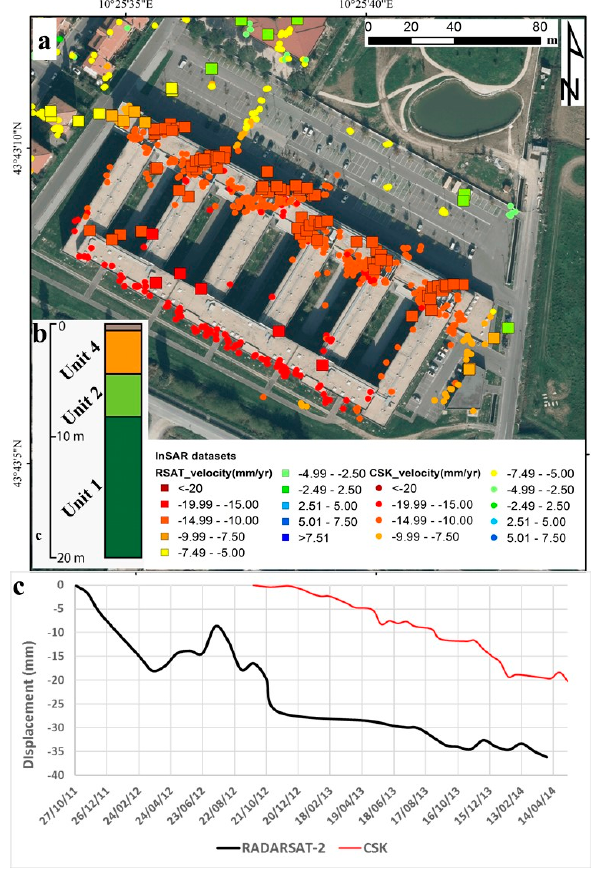
Figure 4. ( a ) LOS displacements affecting the analyzed building. The displacement map is overlaid on a 2013 digital orthophoto; ( b ) Geological reconstruction of the stratigraphical asset, the classification is the one proposed by Sarti et al. [43]; ( c ) RADARSAT-2 and COSMO-SkyMed average time series for the “I Praticelli”